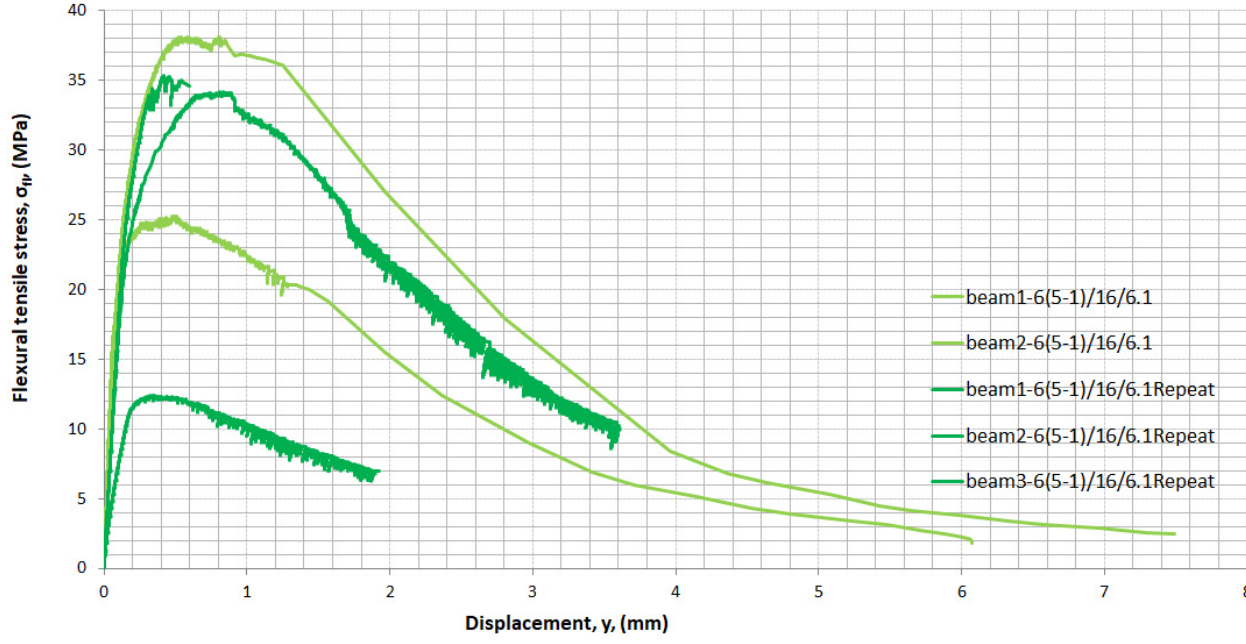
Figure 16. Stress–displacement curves in indirect tension from two mixtures of 6(5-1)/16/6.1.